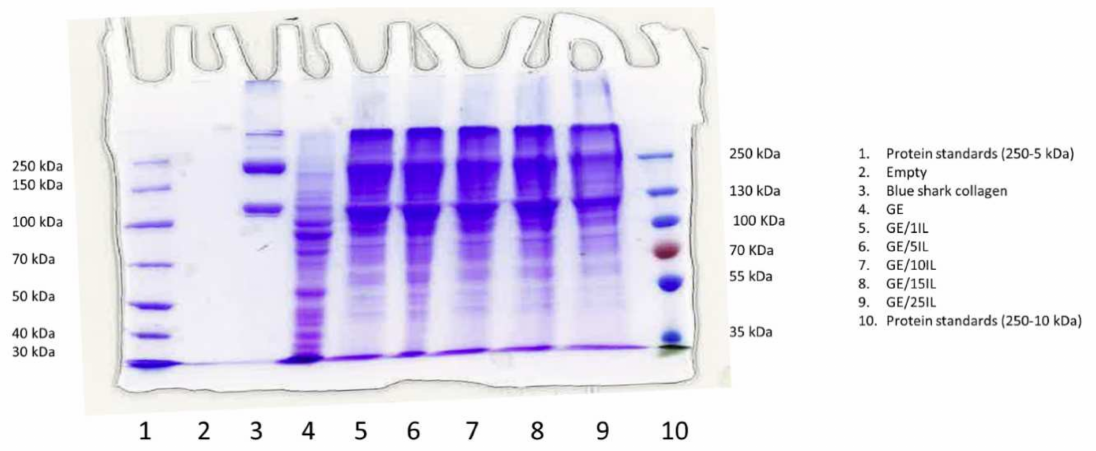
Figure 8. SDS-PAGE of Blue shark collagen and Ionogels with increasing concentration of ionic